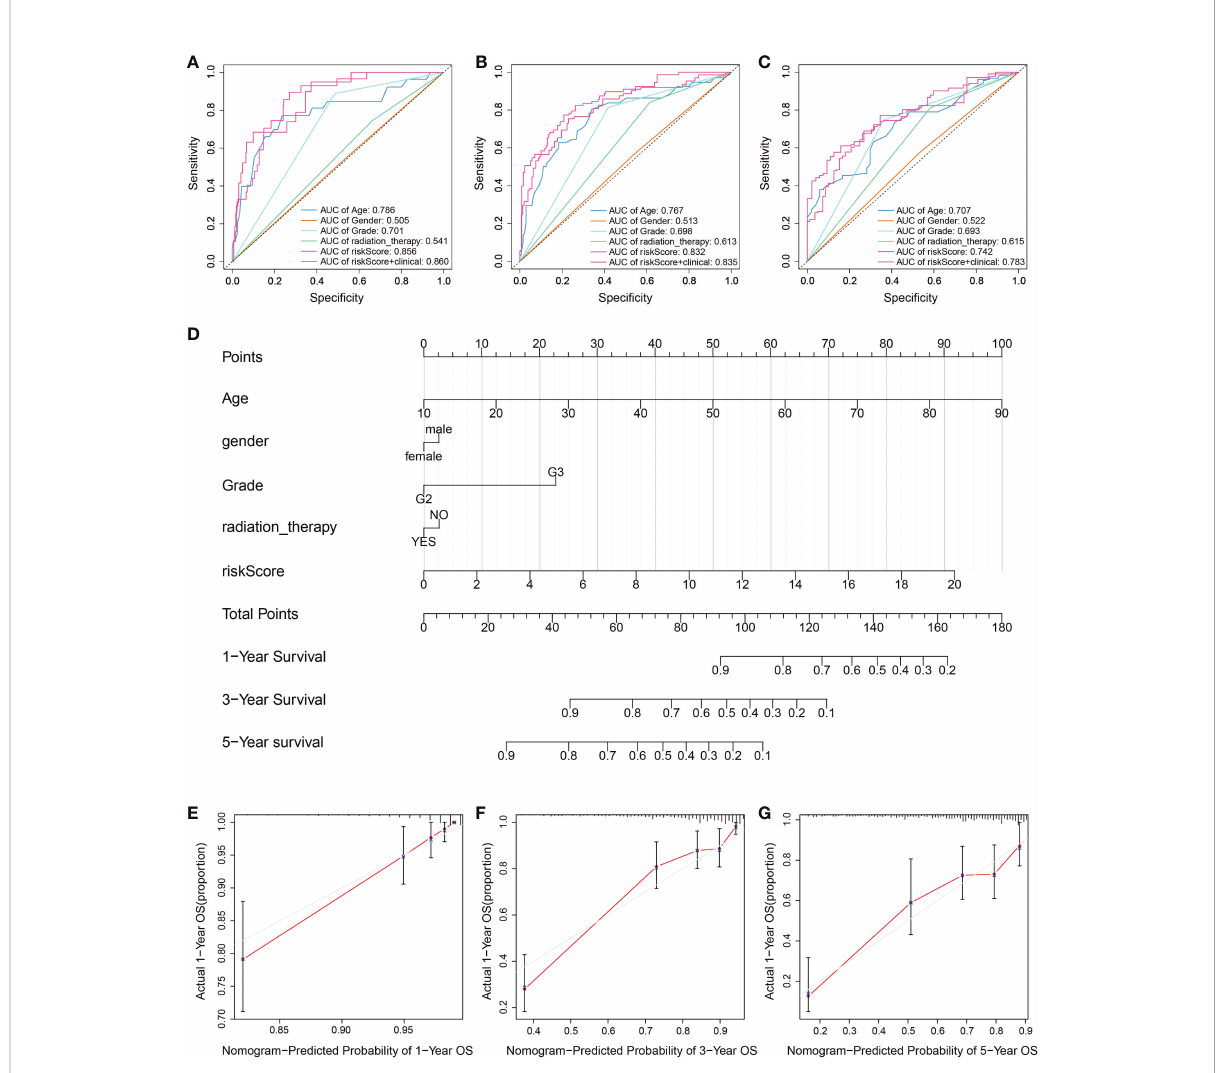
FIGURE 4 Assessment of the risk model combined with clinical factors. (A-C) Time-dependent ROC to evaluate prognostic power based on risk score and clinical factors at (A) 1-year, (B) 3-year, and (C) 5-year. Different colored curves represent different clinical factors. (D) A nomogram consisting of risk score and other clinical indicators for predicting 1-, 3-, and 5-year OS of primary LGG based on the TCGA cohort. (E-G) Nomogram calibration plots for predicting OS in the TCGA cohort at (E) 1-year, (F) 3-year, and (G) 5-year. The Red line indicates actual